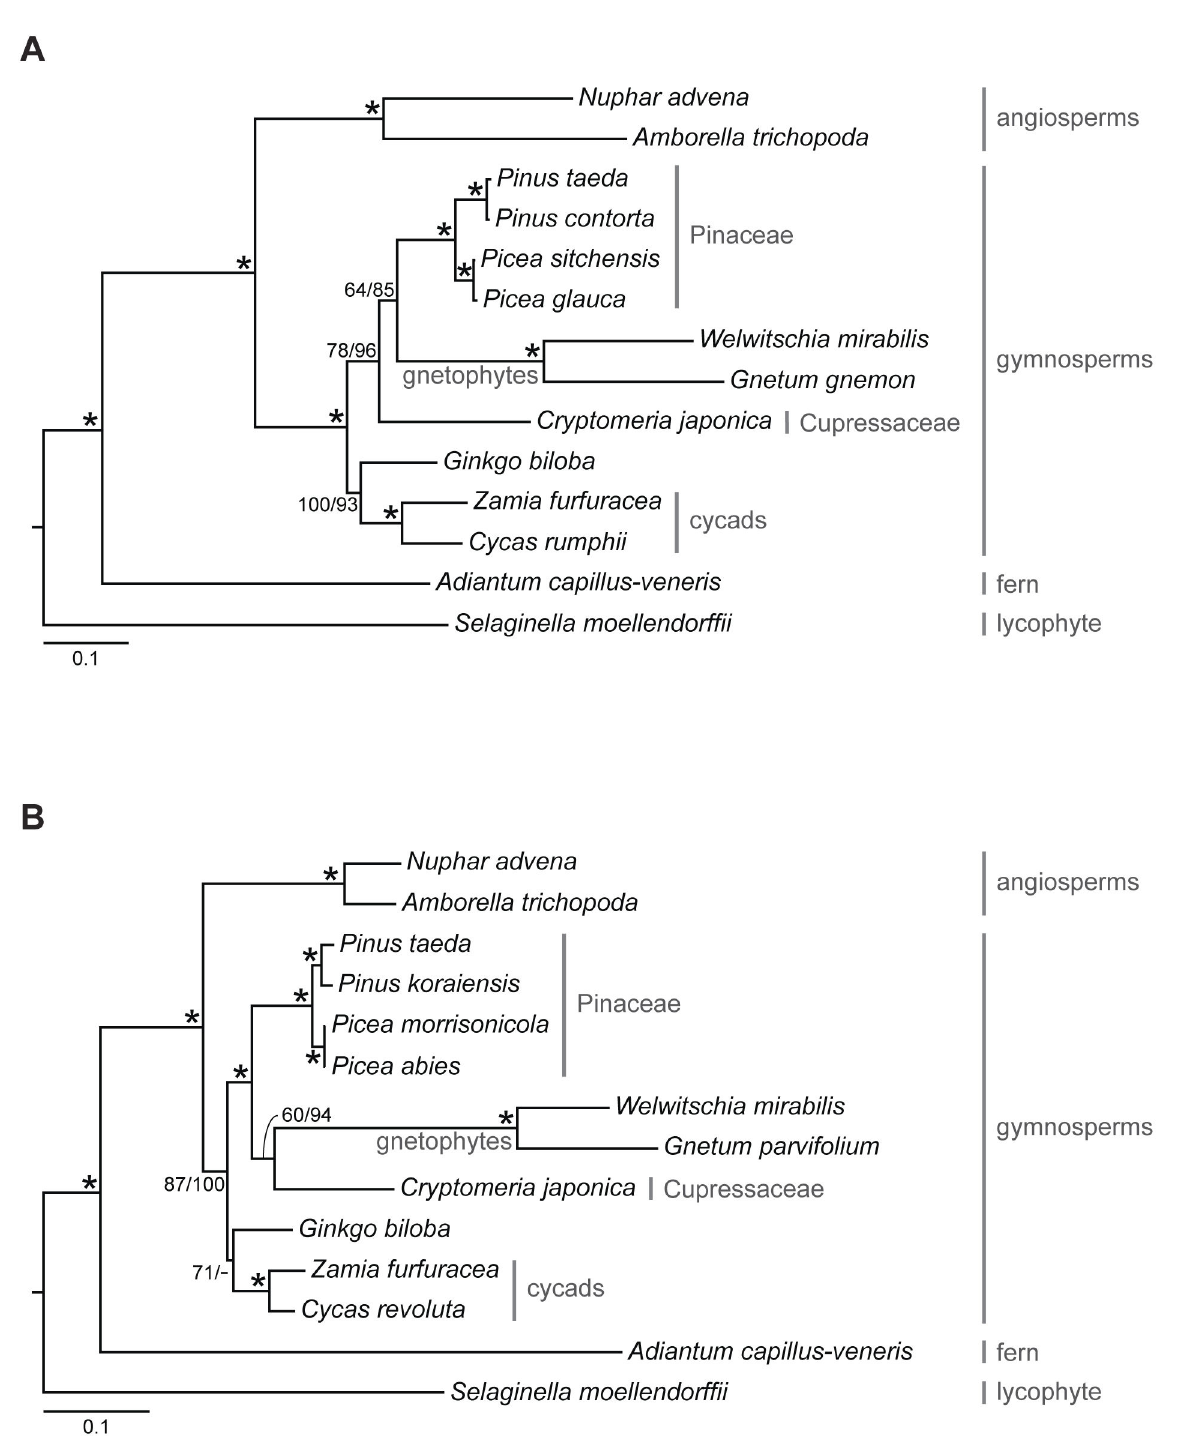
Figure 2. Species trees inferred from (A) 305 nuclear genes and (B) 47 plastid genes using the coalescent method (STAR). Bootstrap percentages (BPs) from STAR/RAxML are indicated above each branch; an asterisk indicates that the clade is supported by 100 BPs from both STAR and RAxML. Branch lengths were estimated by fitting the concatenated matrices to the inferred topology from